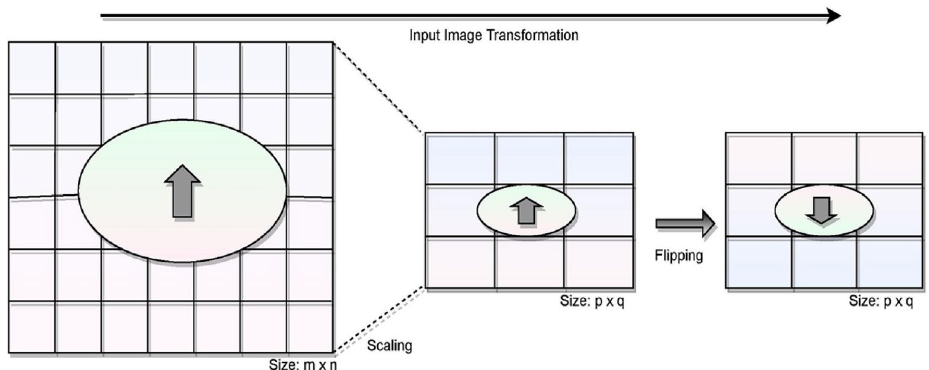
Figure 4. Image presenting the transformation on the input image.